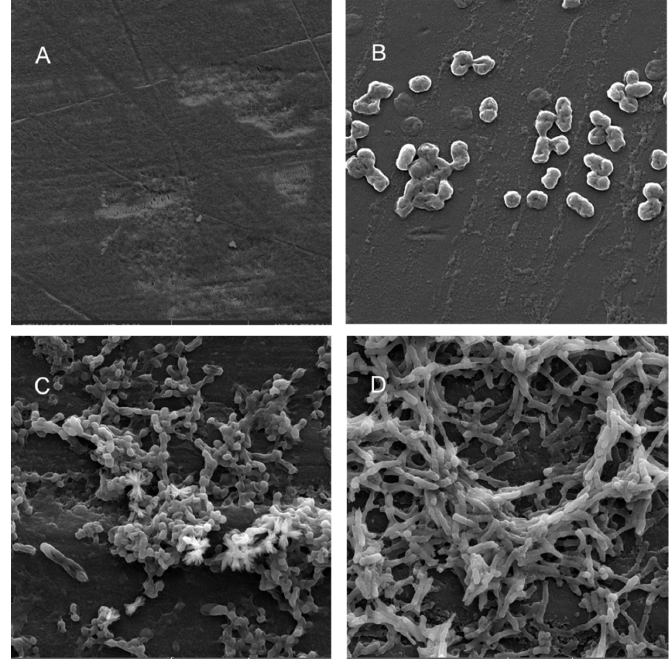
Figure 7. Scanning electron micrographs ( A ) of un ‐ colonized PE (×4980); ( B – D ) of C. freundii in the planktonic phase (×16,800), adherent phase on PE (×10,000) and biofilm phase induced on PE pressed on MacConkey agar (×8300), respectively.